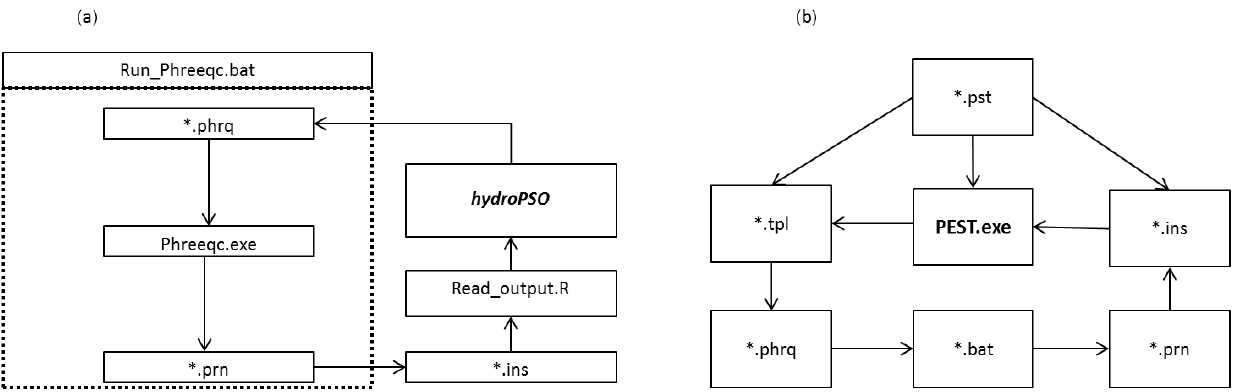
Figure 1. Flow chart used to couple (a) PHREEQC with hydroPSO and (b) PHREEQC with PEST for inverse modeling of surface complex- ation constants for uranium carbonate (U(VI)) species on quartz using the PHREEQC geochemical